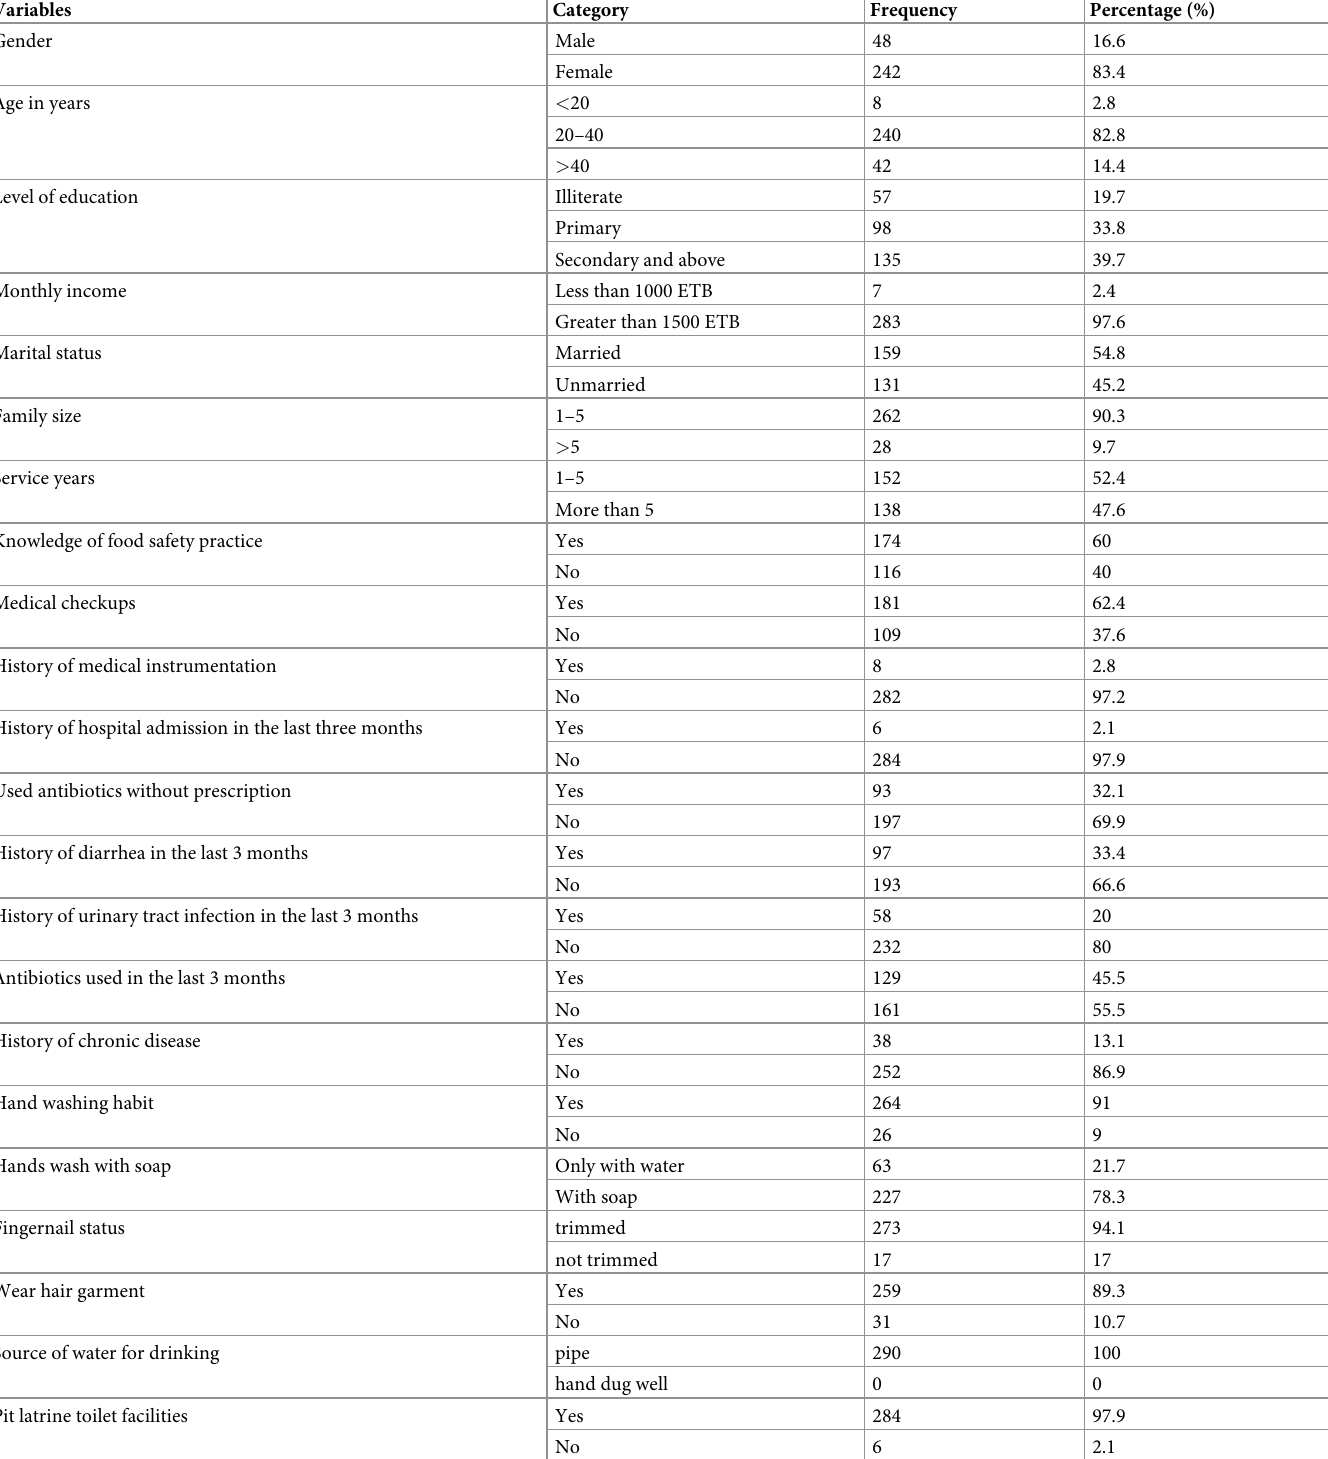
Table 1. Socio-demographic and clinical characteristics, and hygienic practices of food handlers at the University of Gondar Comprehensive Specialized Hospital and Student Cafeteria, Northwest Ethiopia, February to June